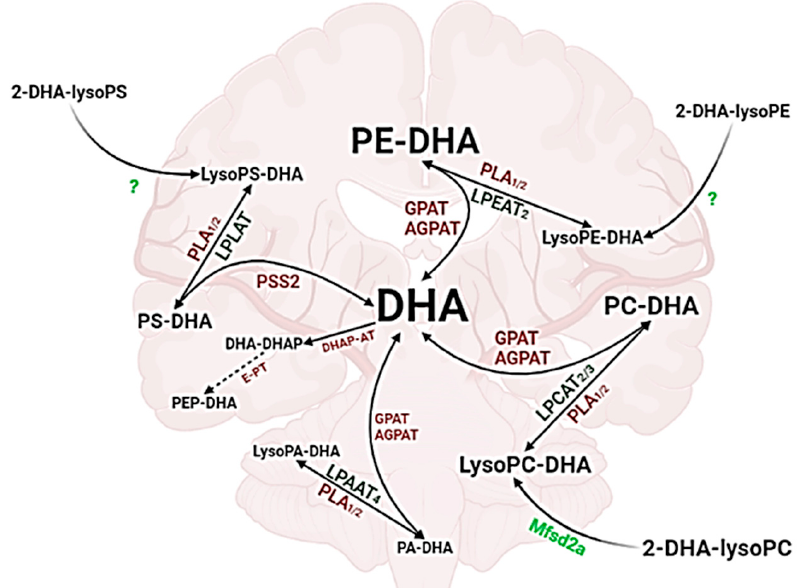
Figure 7. DHA’s de-acylation, re-acylation, and transacylation pathways in brain. DHA: docosahexaenoic acid; PLA: phospholipase A; LPLAT: lysophospholipid acyl transferase; LPEAT: lysophosphatidylethanolamine acyl transferase; LPCAT: lysophosphatidylcholine acyltransferase; LPAAT: lysophosphatidic acid acyltransferase; PSS 2 : phosphatidylserine synthase 2; GPAT: glycerol-3-phosphate acyltransferase; AGPAT: 1-acylglycerol-3-phosphate-O-acyltransferase; DHA-DHAP: dihydroxyacetone phosphate carrying DHA; E-PT: ethanolamine phosphotransferase (Created with BioRender.com accessed on 7 January 2022).